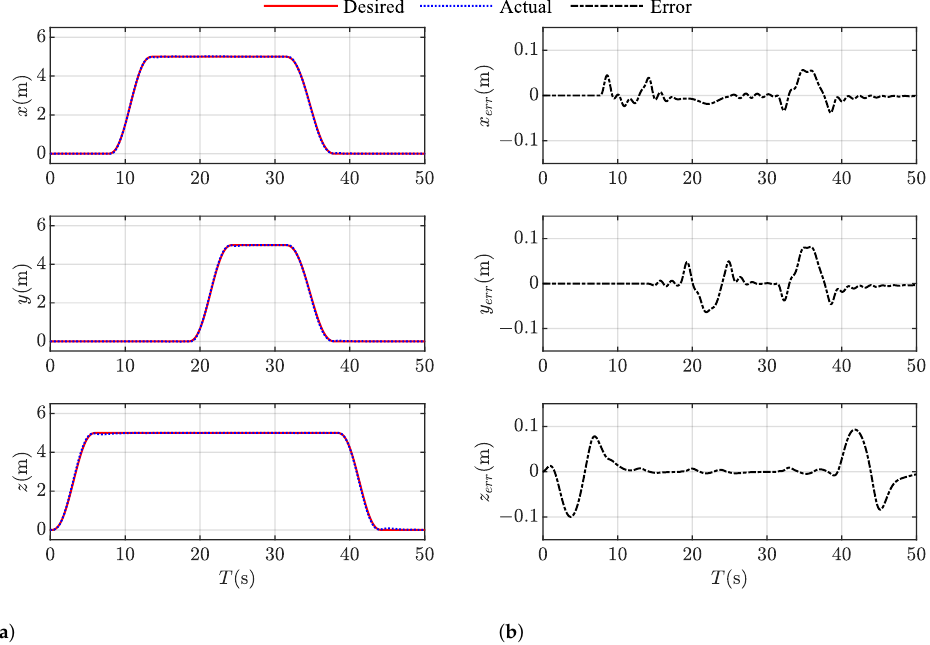
Figure 10. Position tracking in the simulation: ( a ) position tracking response; ( b ) position tracking error.